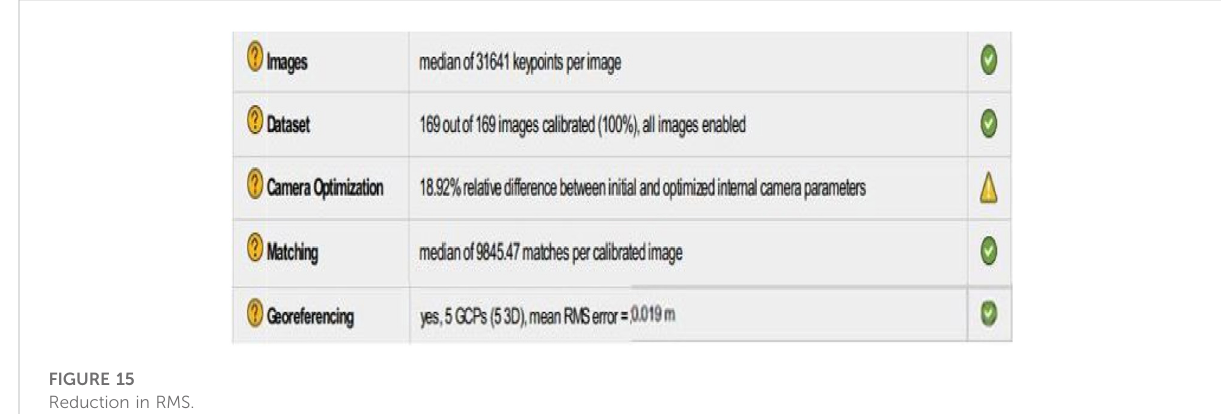
FIGURE 15 Reduction in